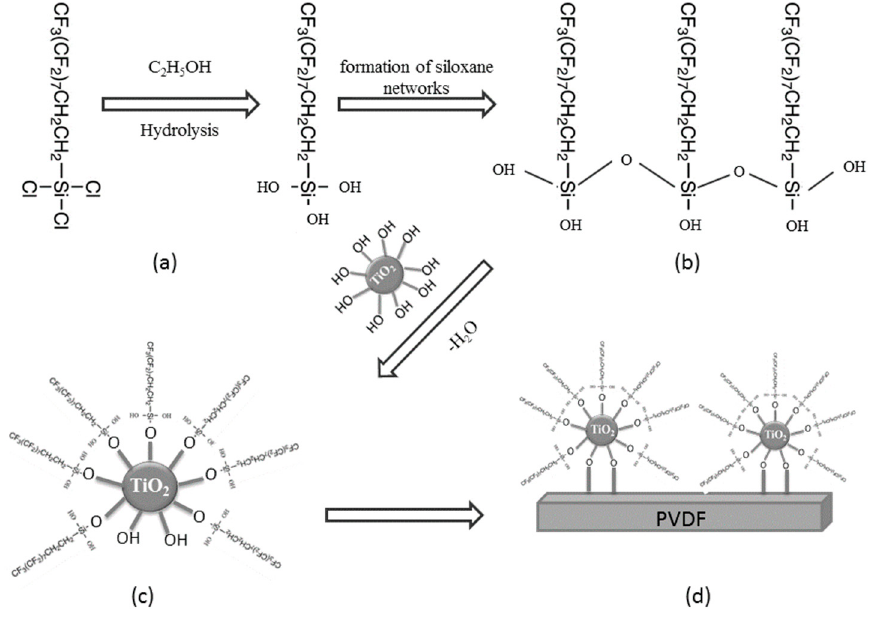
Figure 7. Schematic representation of silanization of the PVDF membranes: ( a ) hydrolysationof trichloro (1H, 1H, 2H, 2H ‐ heptadecafluorodecyl) silane; ( b ) condensation and formation of siloxane networks via covalent bonding; ( c ) interaction with the surface of TiO 2 ; ( d ) incorporation of modified TiO 2 in PVDF dope solution.